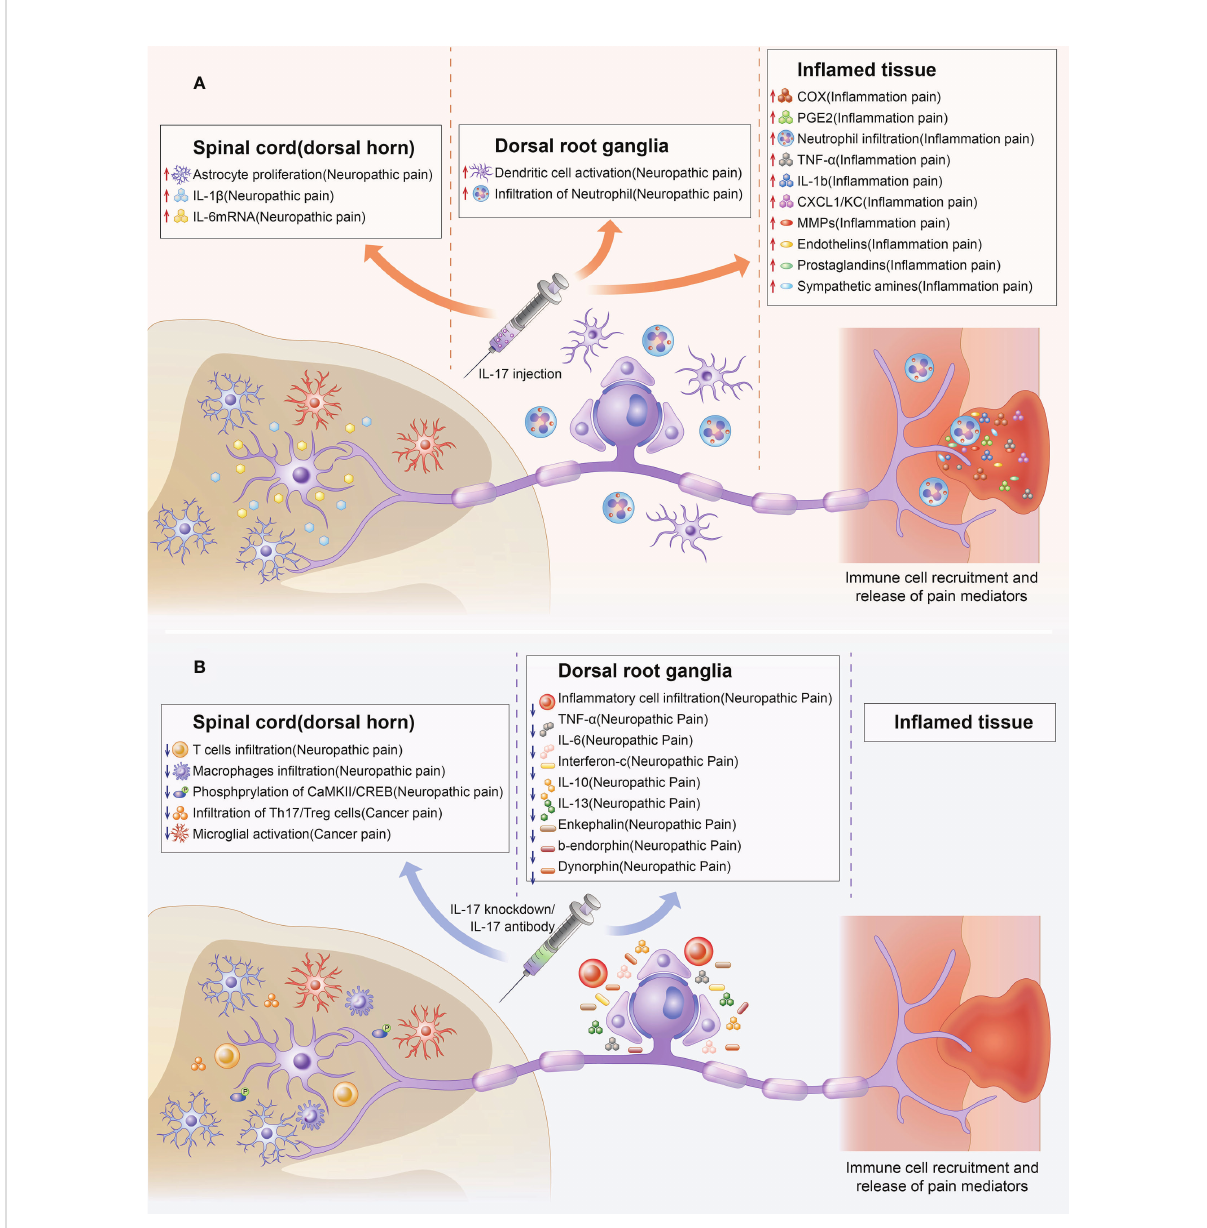
FIGURE 3 Indirect effect of IL-17 in chronic pain. Upregulation and downregulation of IL-17 can mediate chronic pain through chemical signals at several steps of nociceptive transmission. The colored boxes summarize the effects of IL-17 injection and IL-17 knockdown in the preclinical pain models in which they were described. IL-17 can mediate chronic pain by promoting the production of pain factors (such as IL-6,TNF- a , PGE2) and activation of cells (such as astrocyte, microglial, T cells, macrophage in fi ltration) related to chronic pain from spinal cord, DRG, and in fl amed tissue levels. (A) Indirect effect of IL-17 upregulation in chronic pain. (B) Indirect effects of IL-17 knockdown in chronic